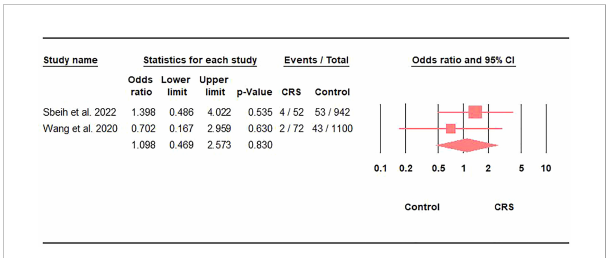
FIGURE 3 Association between the prevalence of mechanical ventilation in COVID-19 and CRS represented by the odds ratio and 95% con fi dence